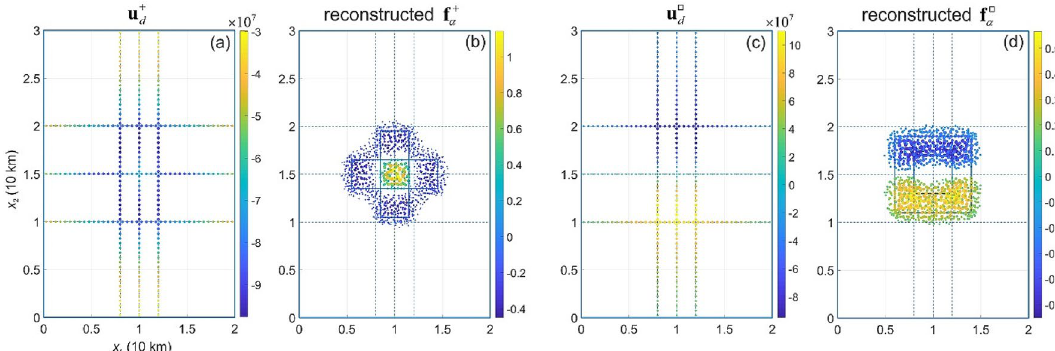
(cid:31) Figure 3. Electric potential u + d ( a ) and u d ( c ) along the paths of synthetic measurements, and the current (cid:31) source density f + α ( b ) and f α ( d ) reconstructed from the synthetic measured